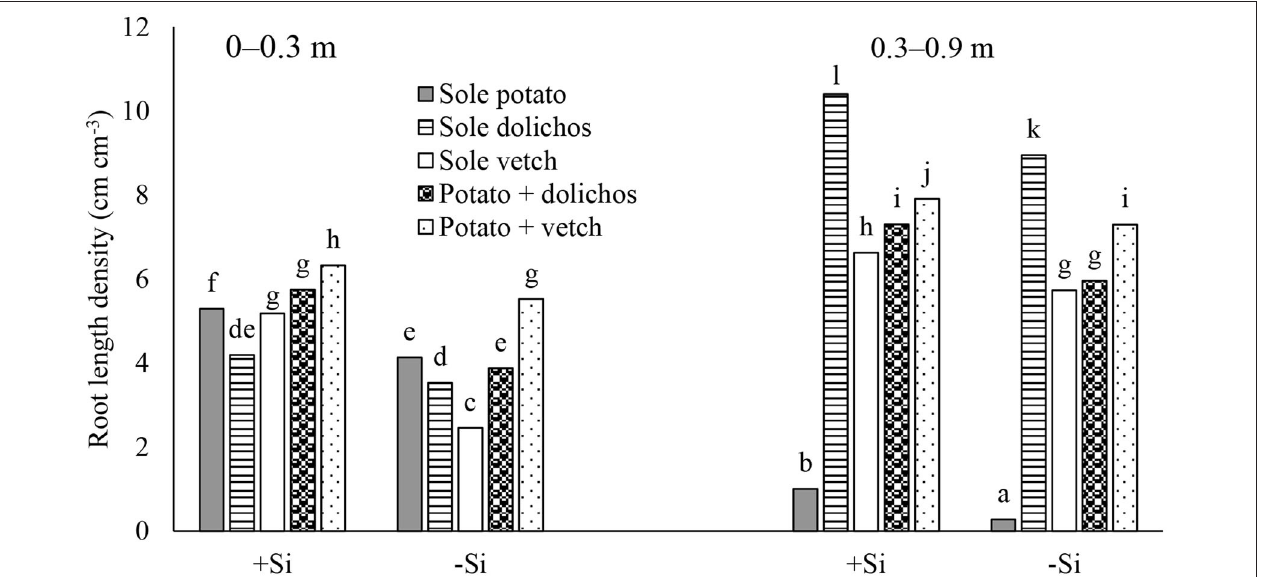
FIGURE 5 | Root length density as affected by intercropping and silicon application. + Si, silicon application; –Si, zero silicon application. Different letters indicate significant differences for means between the cropping systems and Si applications at p ≤ 0.05 by Tukey’s HSD